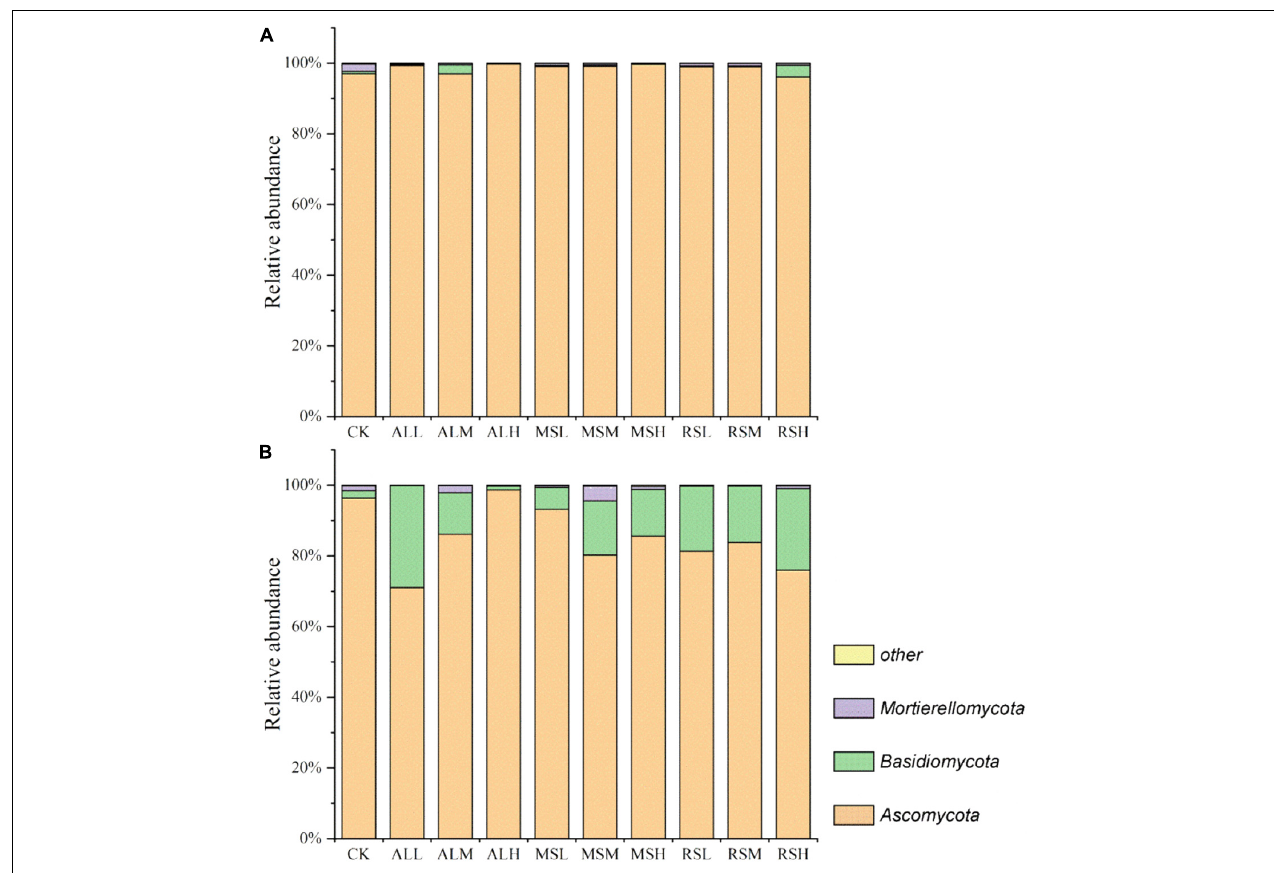
FIGURE 6 | Relative abundances (%) of individual taxonomic groups of the fungal phyla present in samples from the 10 treatments. (A,B) Day 21 and after tomato planting, respectively. The fungal phyla with a relative abundance lower than 1% in all the treatments were clustered as “other.”